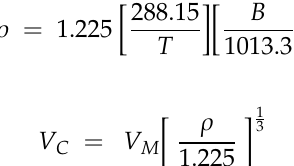
Figure 3. Air density corrected filtered power curve .